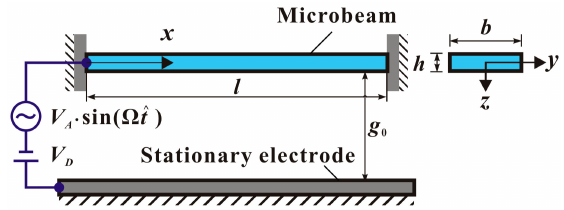
Figure 1. Schematic diagram of a microresonator actuated by one